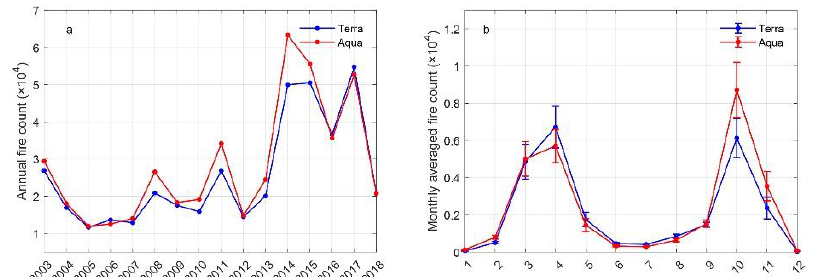
Figure 2. ( a ) Annual total and ( b ) monthly average fire counts in northeastern China during 2003–2018. Error bars indicate one-fifth of the standard deviation.